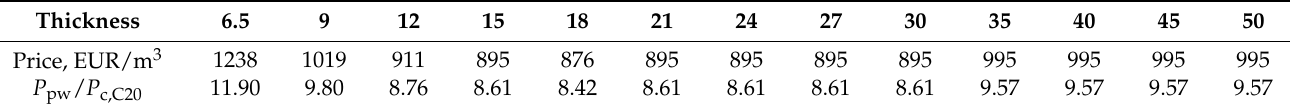
Table 4. Prices of plywood depending on its